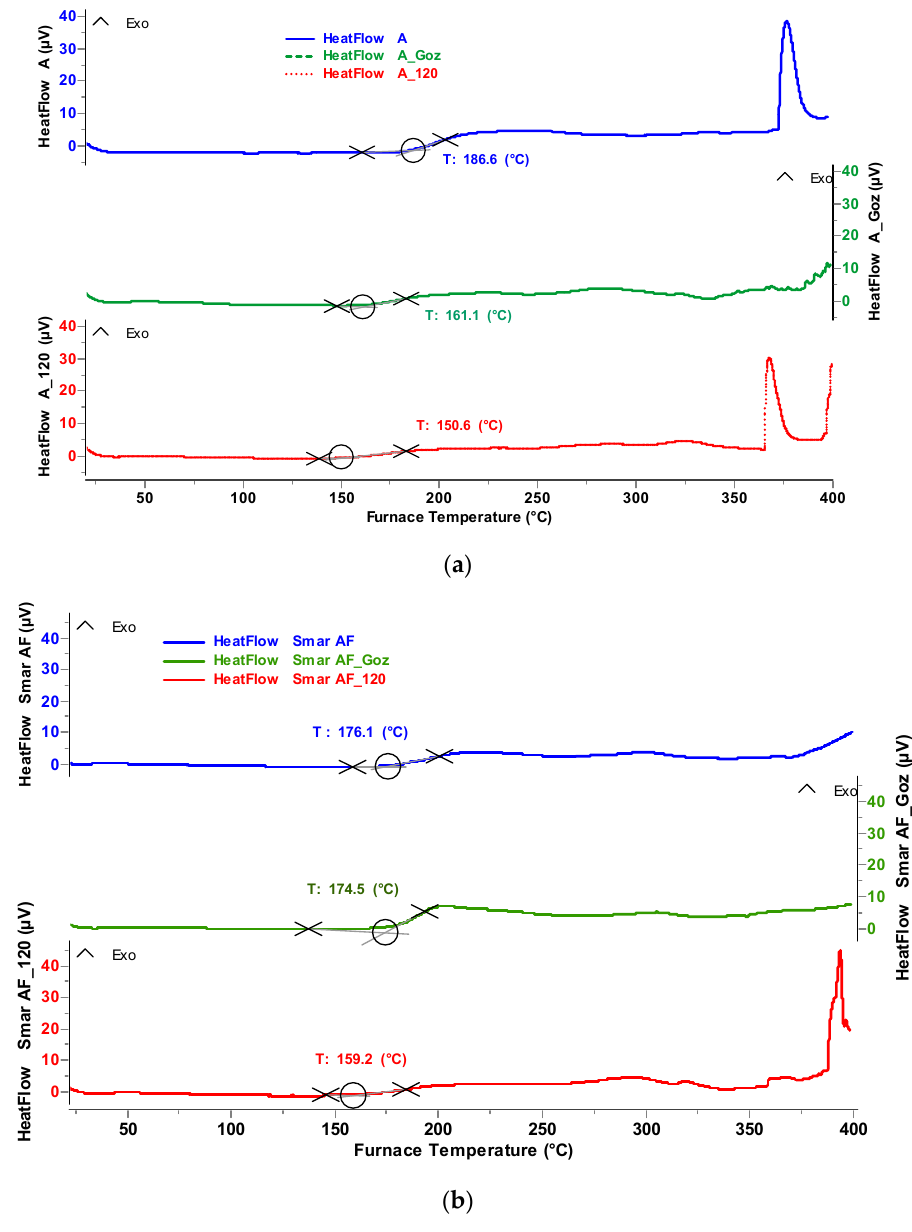
Figure 6. The change of resistance to oxidation after thermo-oxidation and mechanical forces for: ( a ) vegetable grease A, ( b ) vegetable–mineral grease